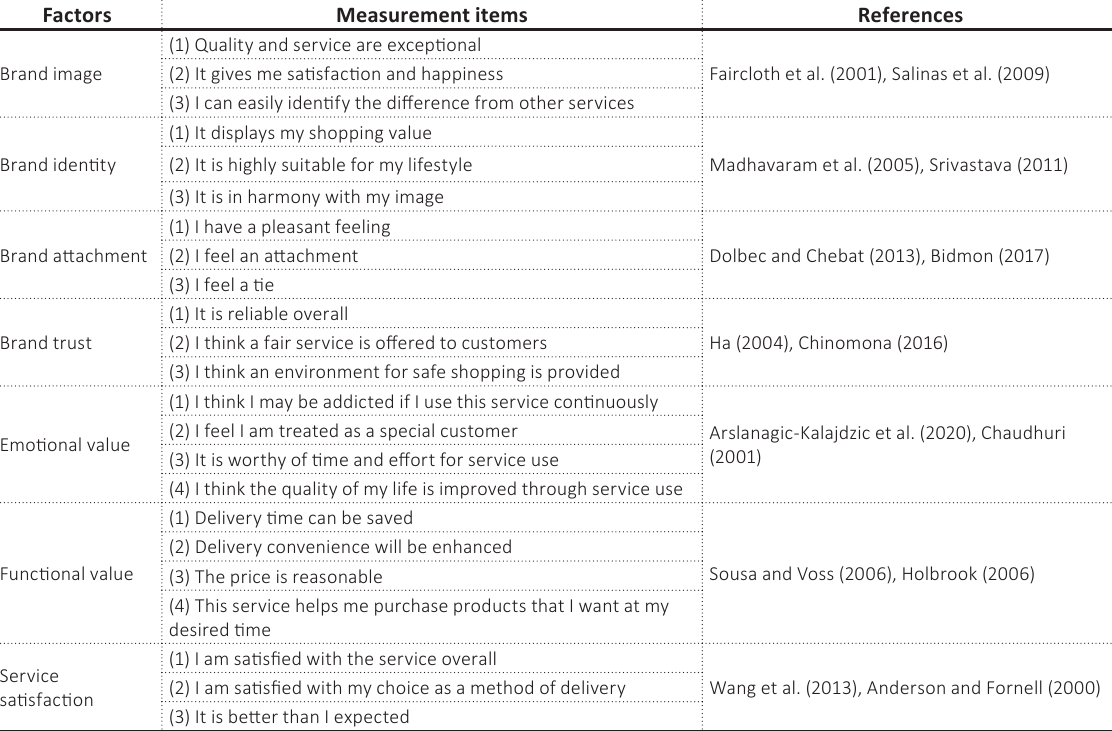
Table 1. Variable definitions and measurement items